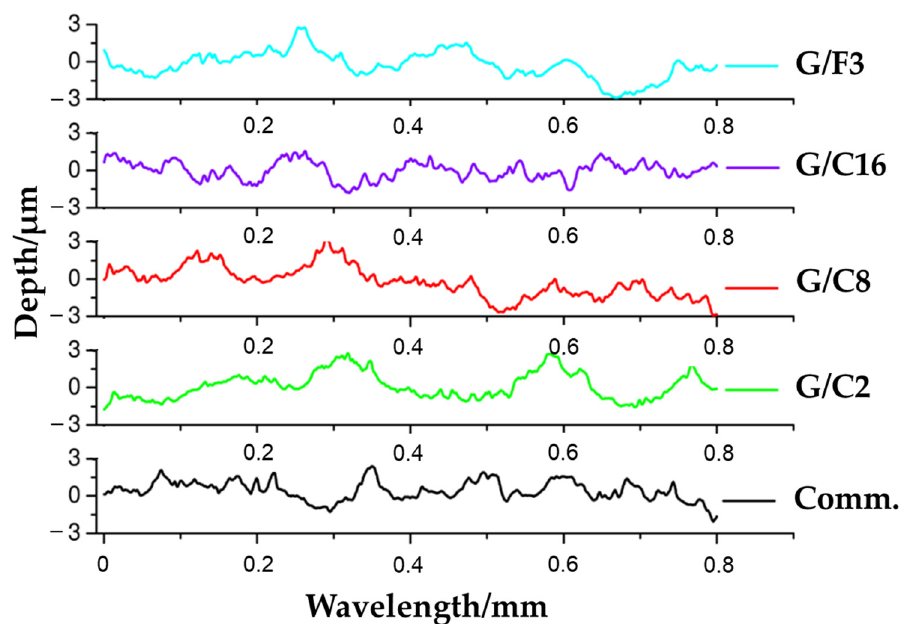
Figure 7. Roughness profiles of antifouling coatings.